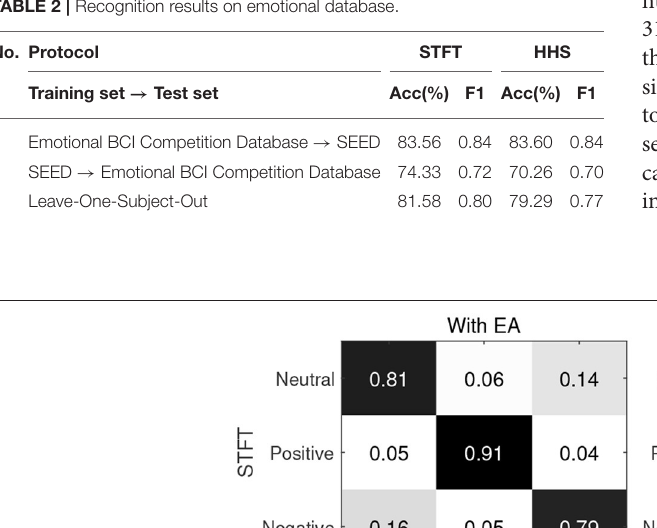
TABLE 2 | Recognition results on emotional database.